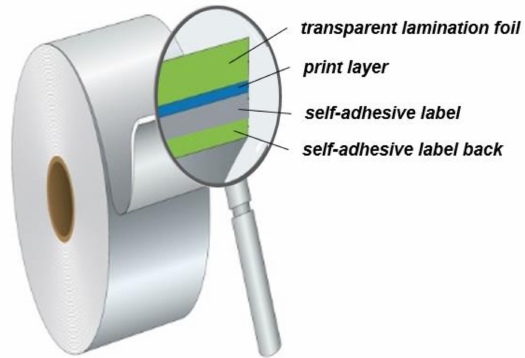
Figure 16. Conceptual schematic on the architecture of a R2R (Rool to Rool) media containing VIS-trigger-able photochromic prints of this work. The functional inks can be printed by any method on self-adhesive R2R-media. The photochromic colorant system is embedded within a polymer matrix that is existent in the ink formulation. In a subsequent step, the prints are covered by a self-adhesive transparent lamination foil to achieve optimum durability of the photochromic